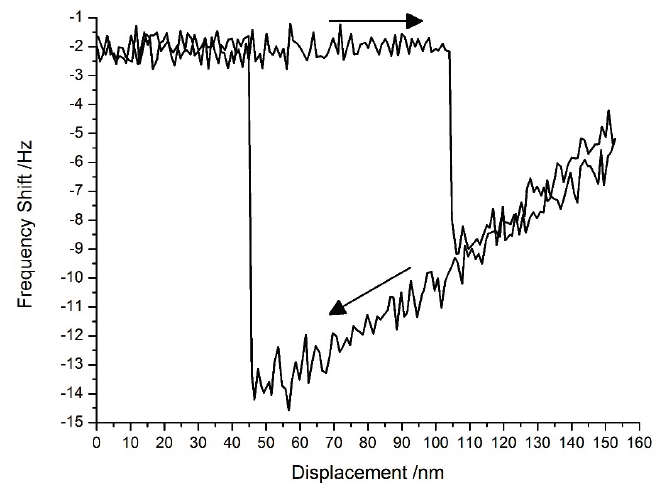
Figure 10. The approach curve for the second eigenmode in FM